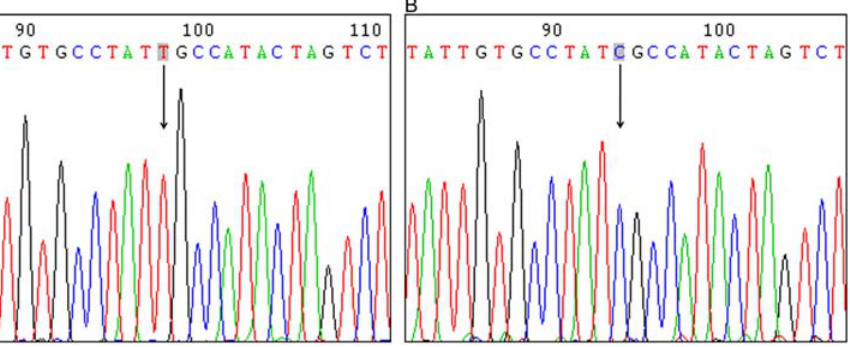
Figure 2. Electropherogram results for direct sequencing of the ND4L T10652C variant. (A) is the ‘T’ allele sequencing result from the lowest heteroplasmic individual used to make the ‘T’ allele clone standard for SNaPshot and allele specific PCR. (B) is the ‘C’ allele sequencing result from the highest heteroplasmic individual detected with microarray (MDD subject from haplogroup D1) used to make the ‘C’ allele clone standard. doi:10.1371/journal.pone.0004913.g002 PLoS ONE |